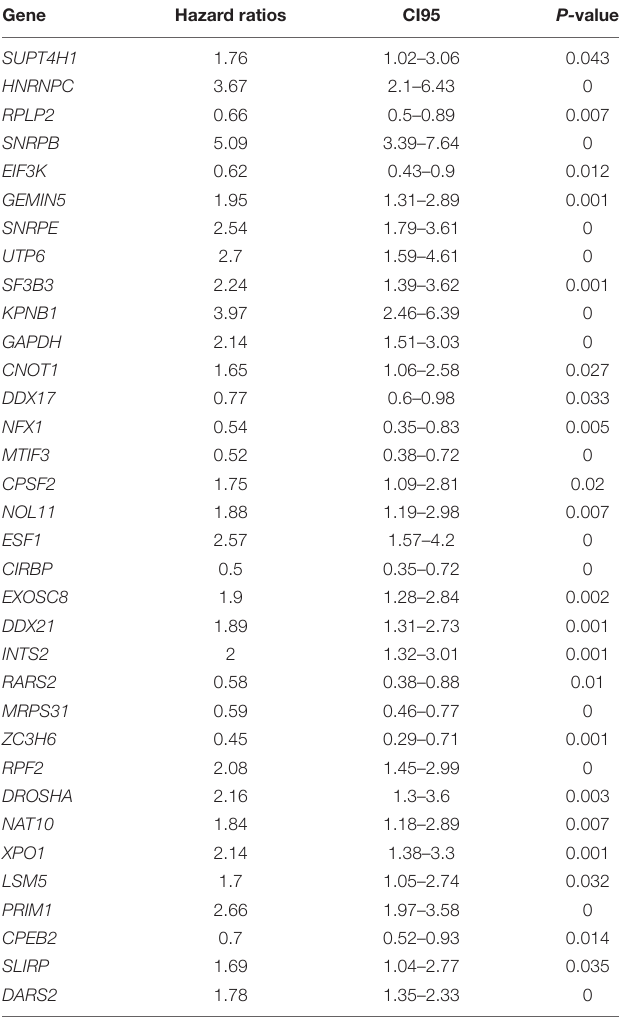
TABLE 1 | Unicox results of differential RNA-binding